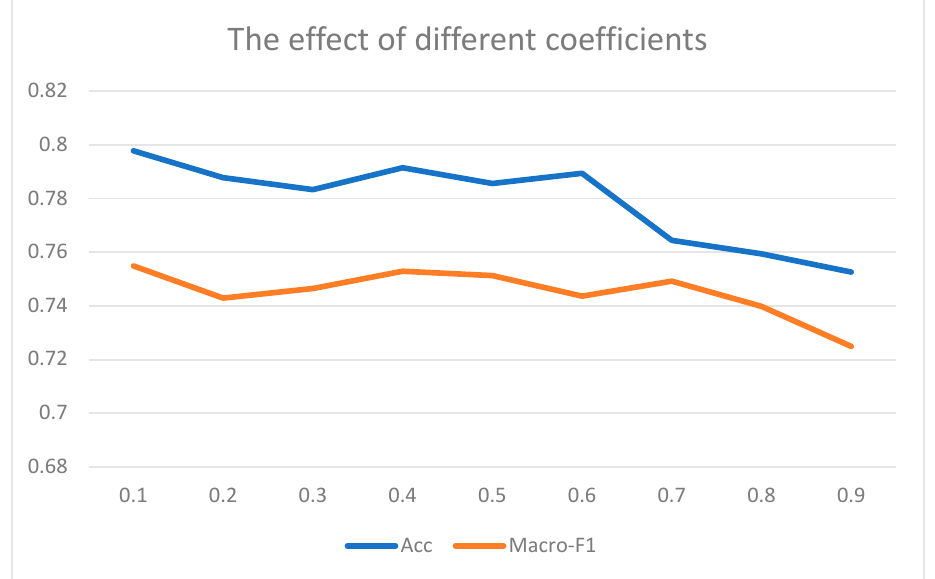
Figure 4. The effect of different coefficients. Figure 4. The e ff ect of di ff erent coe ffi